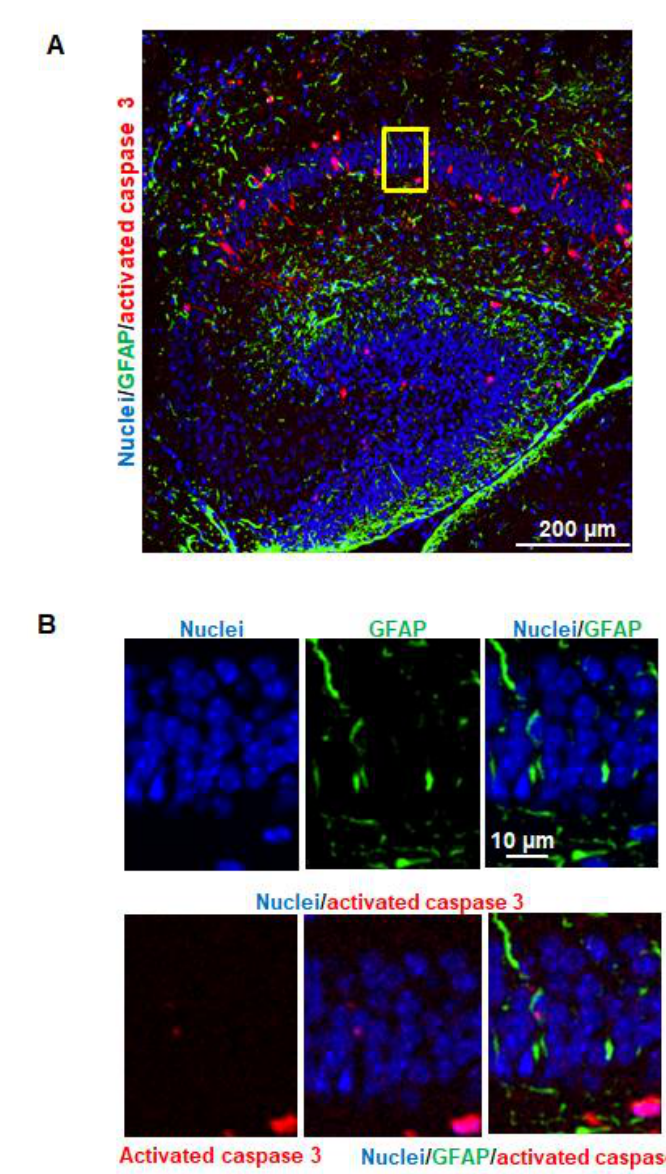
Figure 4. Propofol does not trigger astrocyte apoptosis in the hippocampus. ( A ) Fluorescence images of the hippocampus treated with propofol. The brain sagittal sections were co-stained with activated caspase 3 and glial fibrillary acidic protein (GFAP; astrocyte marker). Cell nuclei were stained with Hoechst 33342. Blue, green, and red represent cell nuclei, GFAP, and activated caspase 3 signals, respectively. Scale bar = 200 µm; ( B ) The magnified view of the yellow-boxed region shown in Figure 4A. These images include the individual channel and overlaid images and show that activated caspase 3 and GFAP signals were not co-localized in the same cells, indicating that propofol does not cause astrocyte apoptosis. Scale bar = 10 µm.